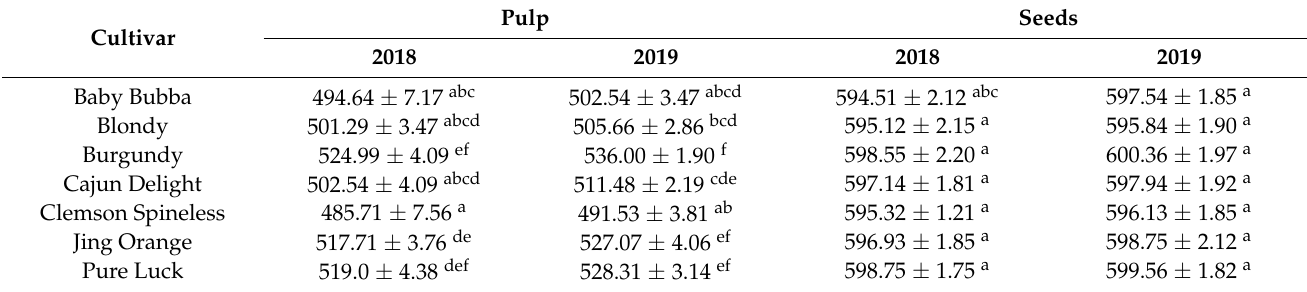
Table 4. Antioxidant activity of okra cultivars (mg TEAC kg − 1 d.w.).